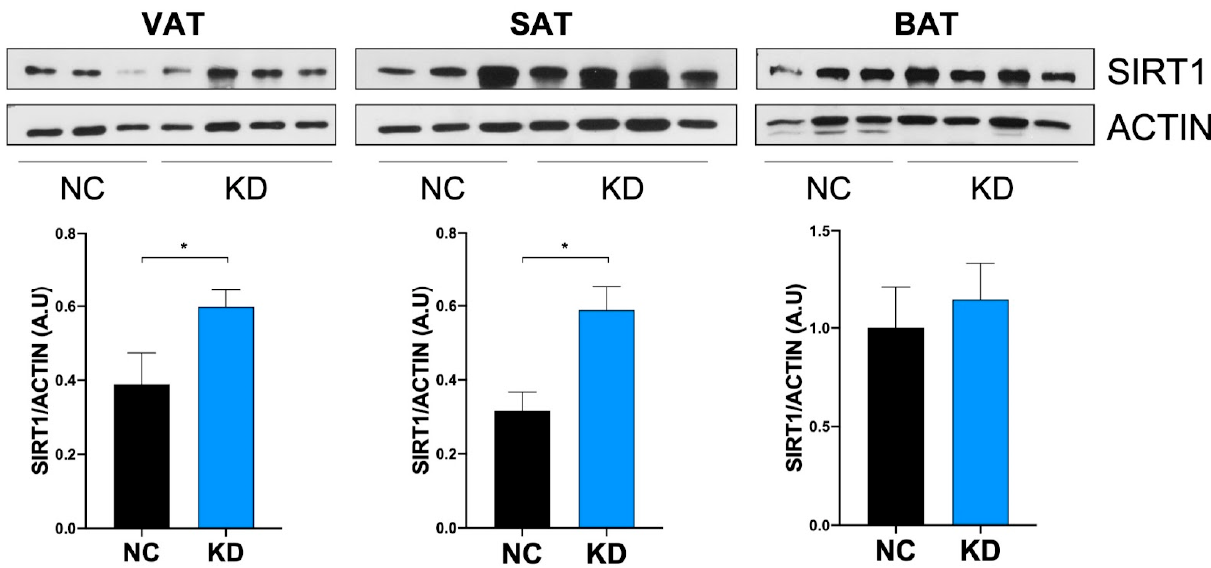
Figure 4. Ketogenic diet effect on adipose tissue levels of SIRT1. Western Blotting analysis of SIRT1 expression on visceral adipose tissue (VAT), subcutaneous adipose tissue (SAT), and interscapular brown adipose tissue (BAT) extracts from mice under normal chow (NC, n = 6) and ketogenic diet (KD, n = 10) at the end of dietary treatment. Densitometric analyses show protein expression levels expressed as arbitrary units ± SEM. * p <